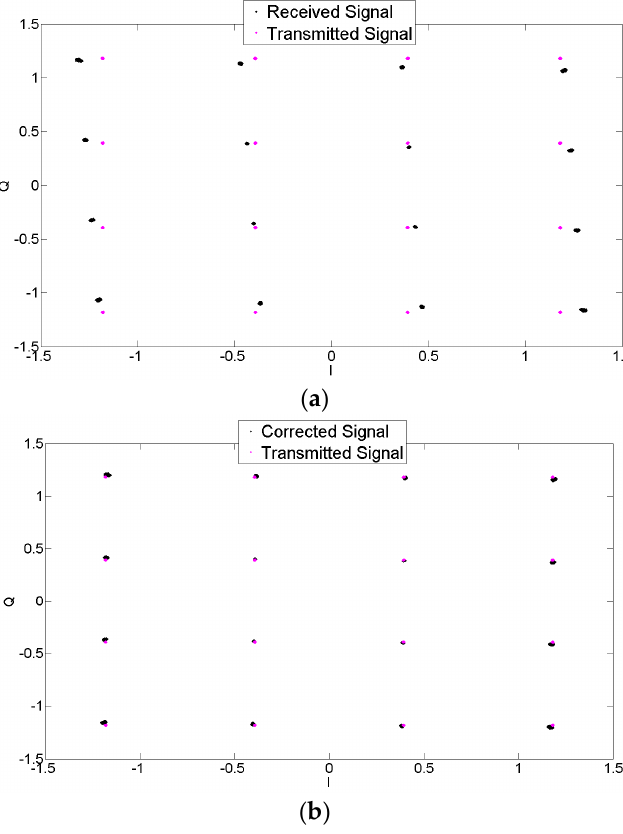
Figure 14. Constellation of 16 QAM ( a ) transmitted and received signals and ( b ) transmitted and corrected signals.